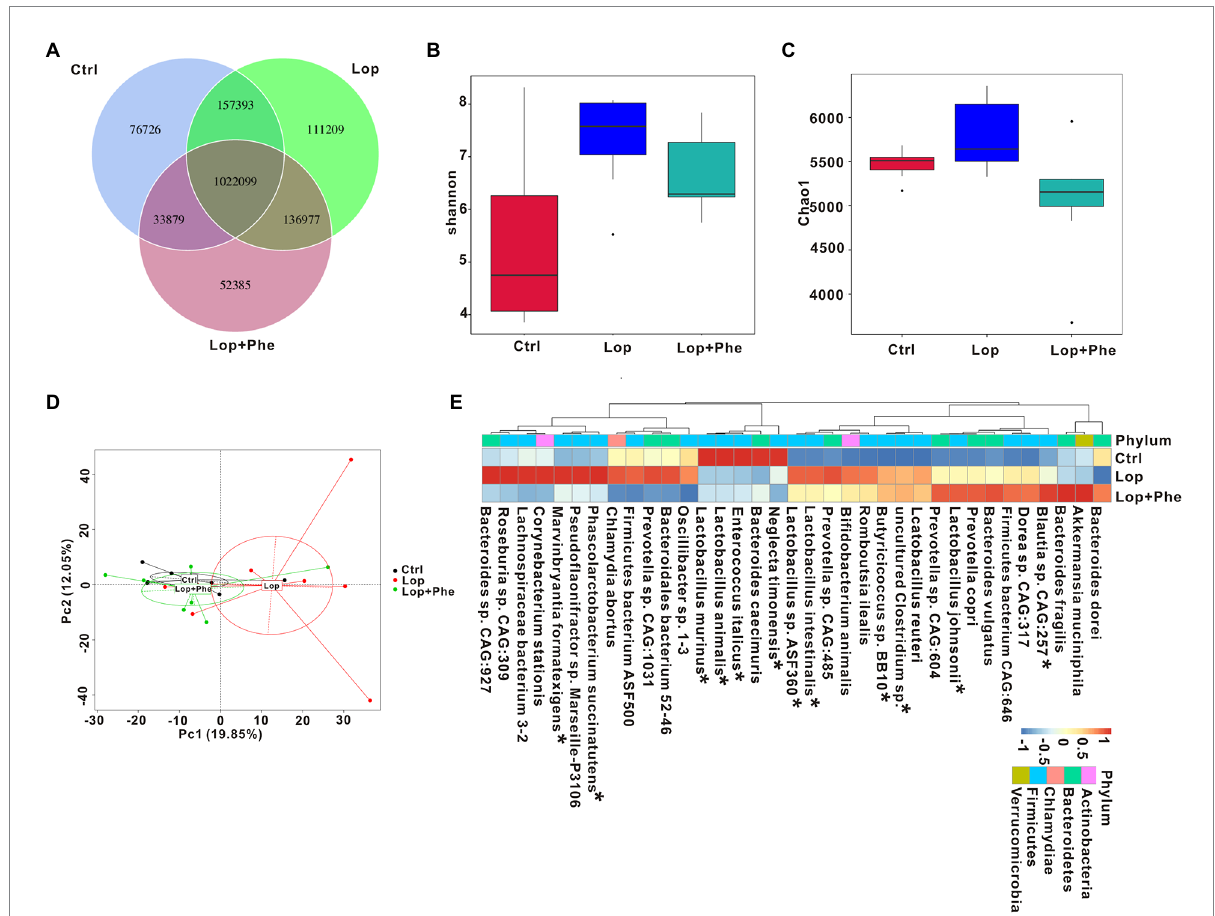
FIGURE 2 Phe reverses dysbiosis of the gut microbiota in constipated rats, as revealed by metagenomics sequencing data. (A) Venn diagram depicting the number of shared (overlap) and unique (non-overlap) genes among the Ctrl, Lop, and Lop + Phe groups. (B,C) Alpha-diversity index for the three groups at the species level. Shannon index (B) and Chao index (C) . (D) Beta diversity as determined using PCA plots. (E) Heatmap comparison between the three groups at the species level. * p < 0.05, Kruskal–Wallis H